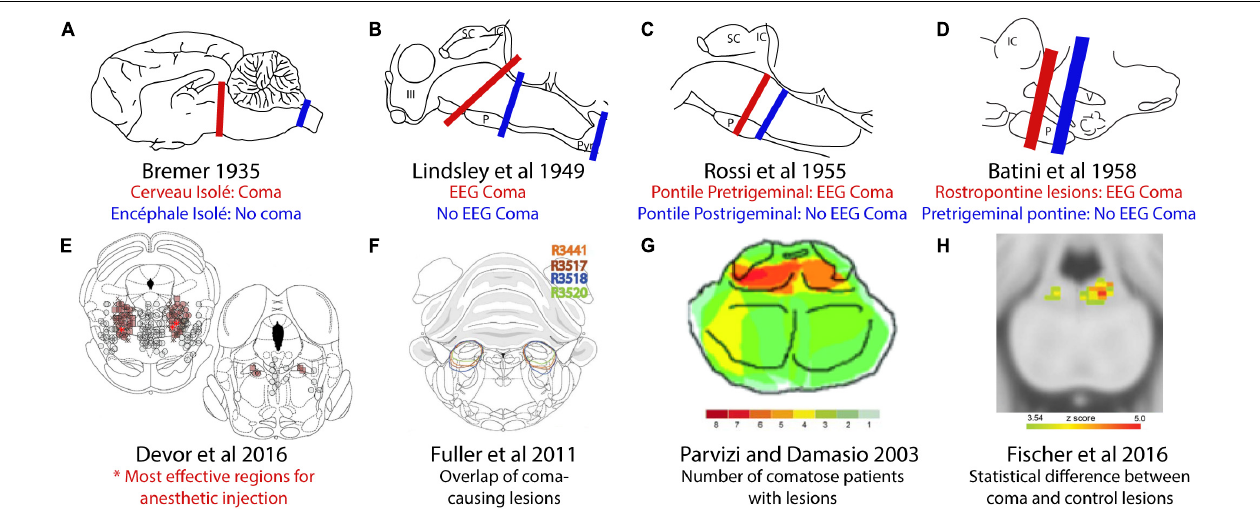
FIGURE 1 | Comparison of coma-causing and non-coma-causing lesions in the brainstem. (A) Bremer’s cerveau isolé midbrain transections caused coma but encéphale isolé transections between the brainstem and spinal cord did not. (B) Later, rostral pontine transections caused coma, but more caudal transections did not. (C) An iterative search for the coma-causing region identified a small region of the rostral pons. (D) Transections at a different angle identified the importance of the pontine tegmentum. (E) Micro-injection of the anesthetic pentobarbital produced anesthesia at the lowest doses in the pons-midbrain tegmentum. (F) Orexin-saporin lesions of the parabrachial region caused coma. (G) Overlap analysis of patients with coma-causing lesions identified a similar area of the human brainstem. (H) Subsequent comparison of coma-causing versus control lesions identified a more focal region of the human pontine tegmentum. This figure adopted from Devor and Zalkind